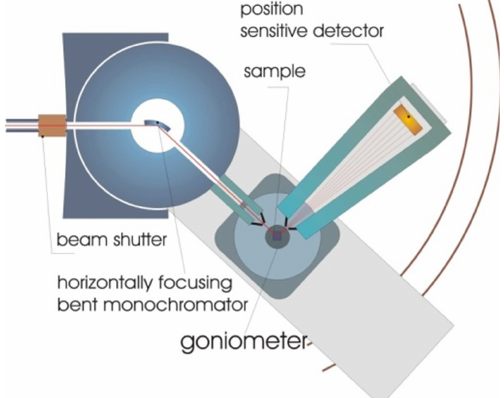
Figure 13. A schematic sketch of the SPN100 instrument for mapping residual stresses in polycrystalline materials